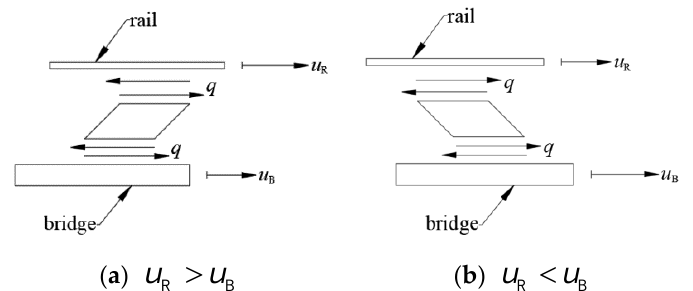
Figure 3. Longitudinal track–bridge coupling element.